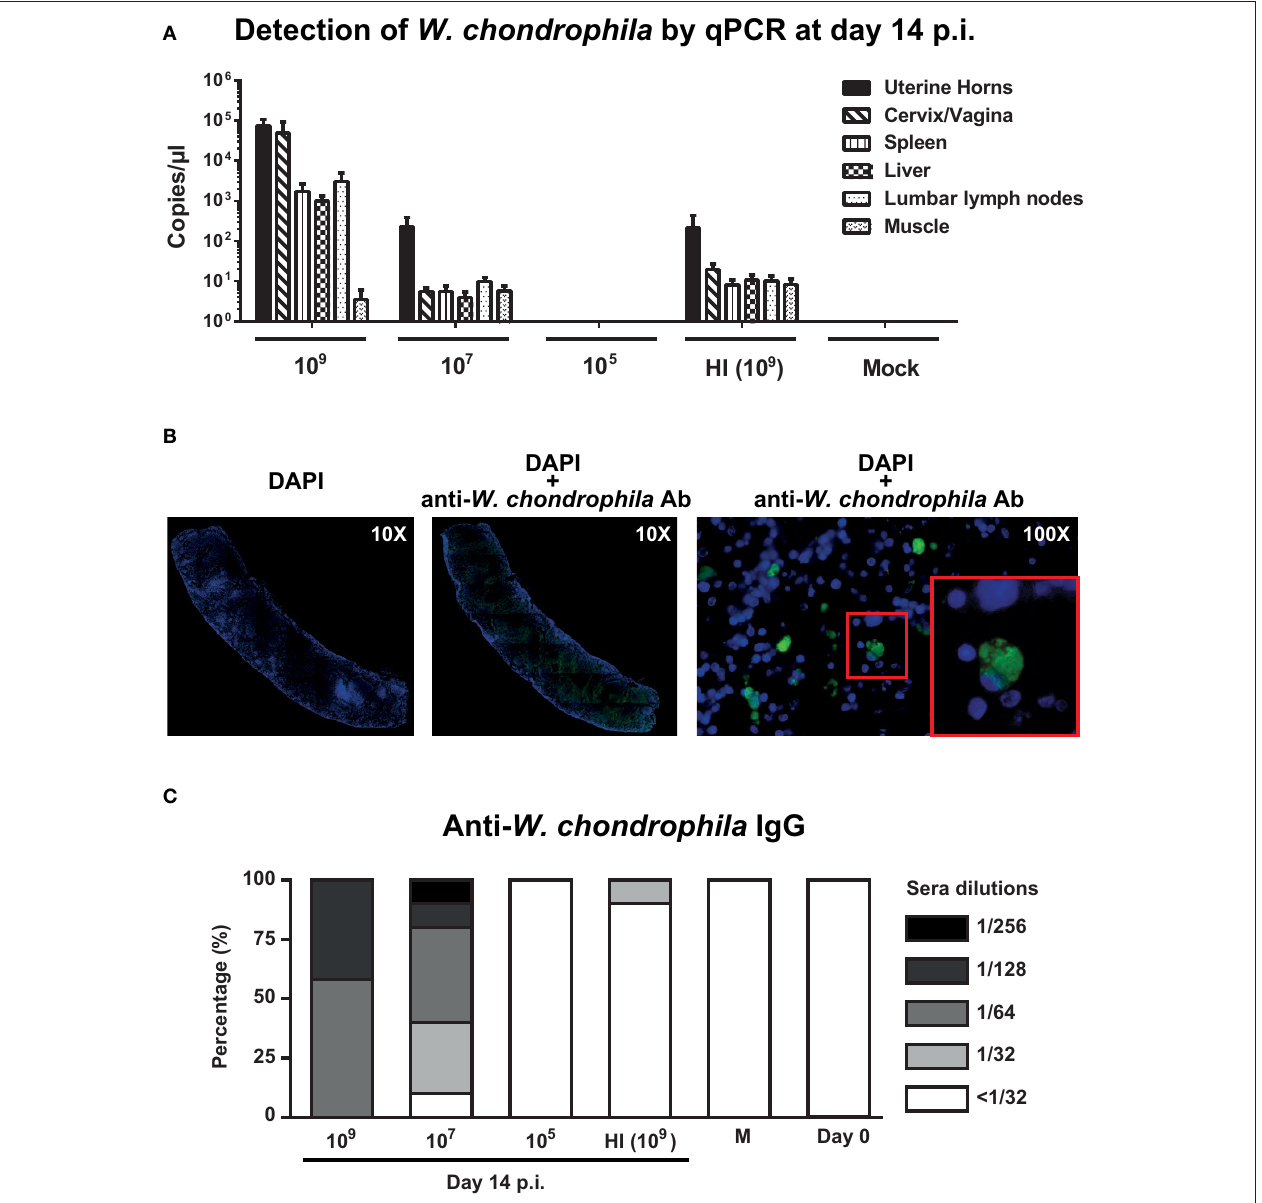
FIGURE 1 | Bacterial burden in genital and non-genital organs and anti- W. chondrophila IgG titers. Mice were infected with decreasing amounts of live (10 9 , 10 7 , 10 5 ) and HI (10 9 ) W. chondrophila . (A) Organ bacterial burden measured by qPCR on day 14 p.i. qPCR values represent the mean SEM. Results are representative of two independent experiments with n = 3 and 5 for each experiment. (B) Detection of W. chondrophila by immunofluorescence in a spleen section at day 14 p.i. Left: visualization of mouse cells by DAPI (10X). Middle: co-visualization of mouse cells by DAPI and bacteria by a specific anti- W. chondrophila antibody (10X). Right: magnification of the co-visualization experiment (100X). Red square depicts a 200X magnification. (C) IgG measured by MIF at day 14 p.i. Day 0 represents naive mice before challenge with W. chondrophila andM represents mock challenged mice. Results are representative of two individual experiments with n = 5 for each